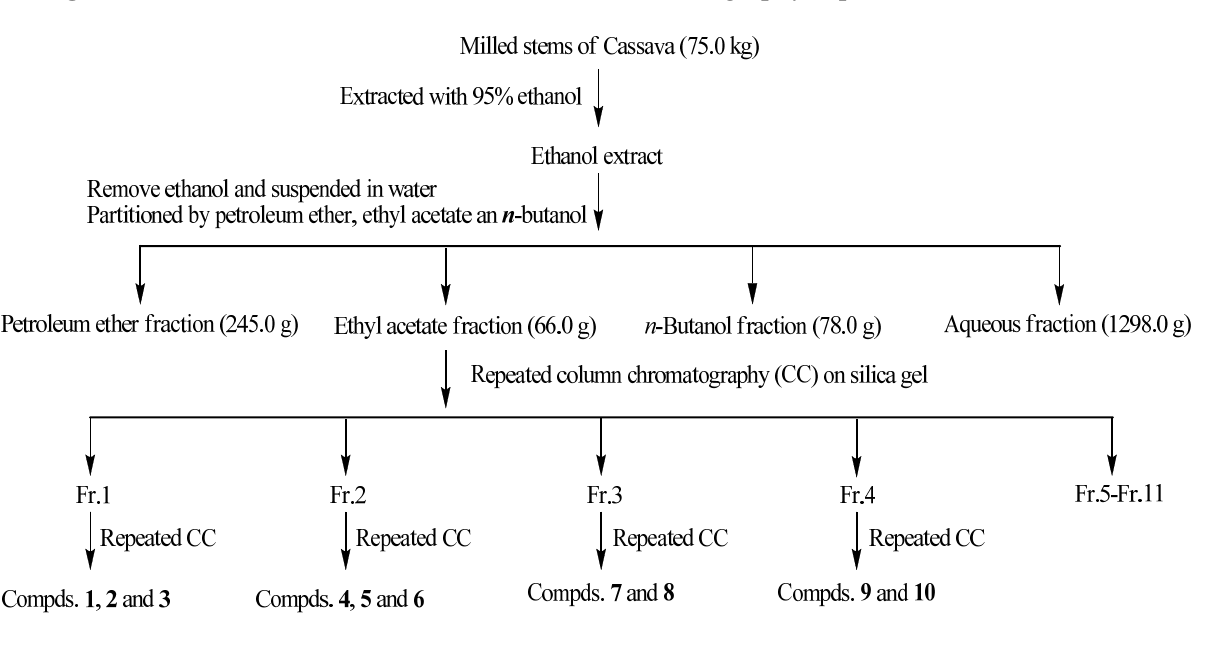
Figure 1. Extraction, fractionation and column chromatography separation of cassava stems.